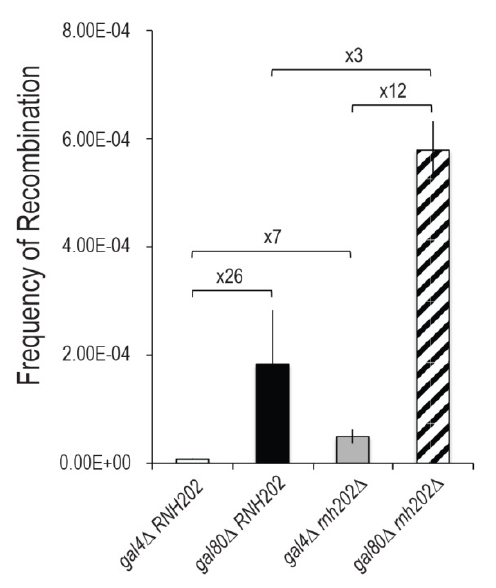
FIGURE 2: Transcription stimulation of recombination is inde- pendent of rnh202 stimulation of recombination. Recombination between duplicated gal10 genes at the GAL10 locus as a function of transcription status is shown as median rates with standard deviations ( n = 27). Low transcription occurs in gal4 ∆ strains while high transcription occurs in gal80 ∆ strains. Fold differences be- tween indicated genotypes are